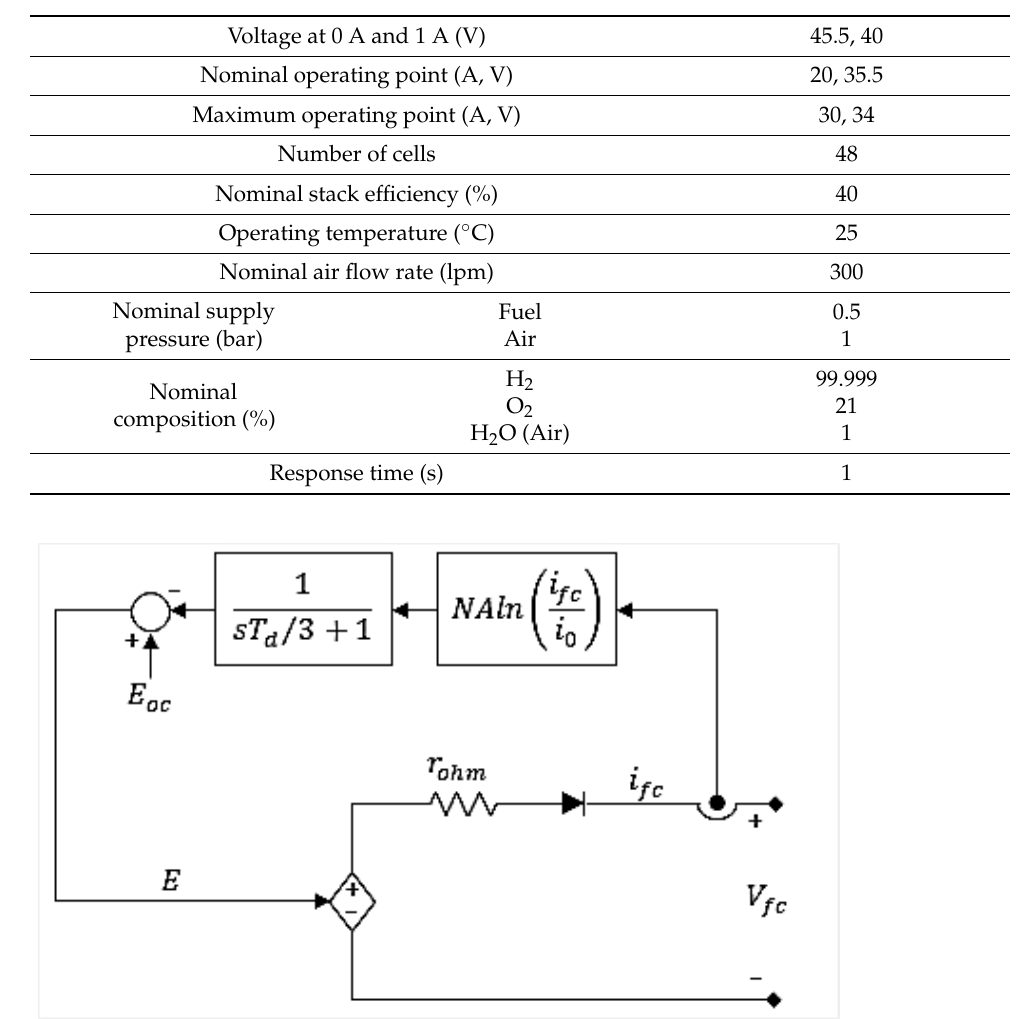
Table 4. Fuel cell model parameters.